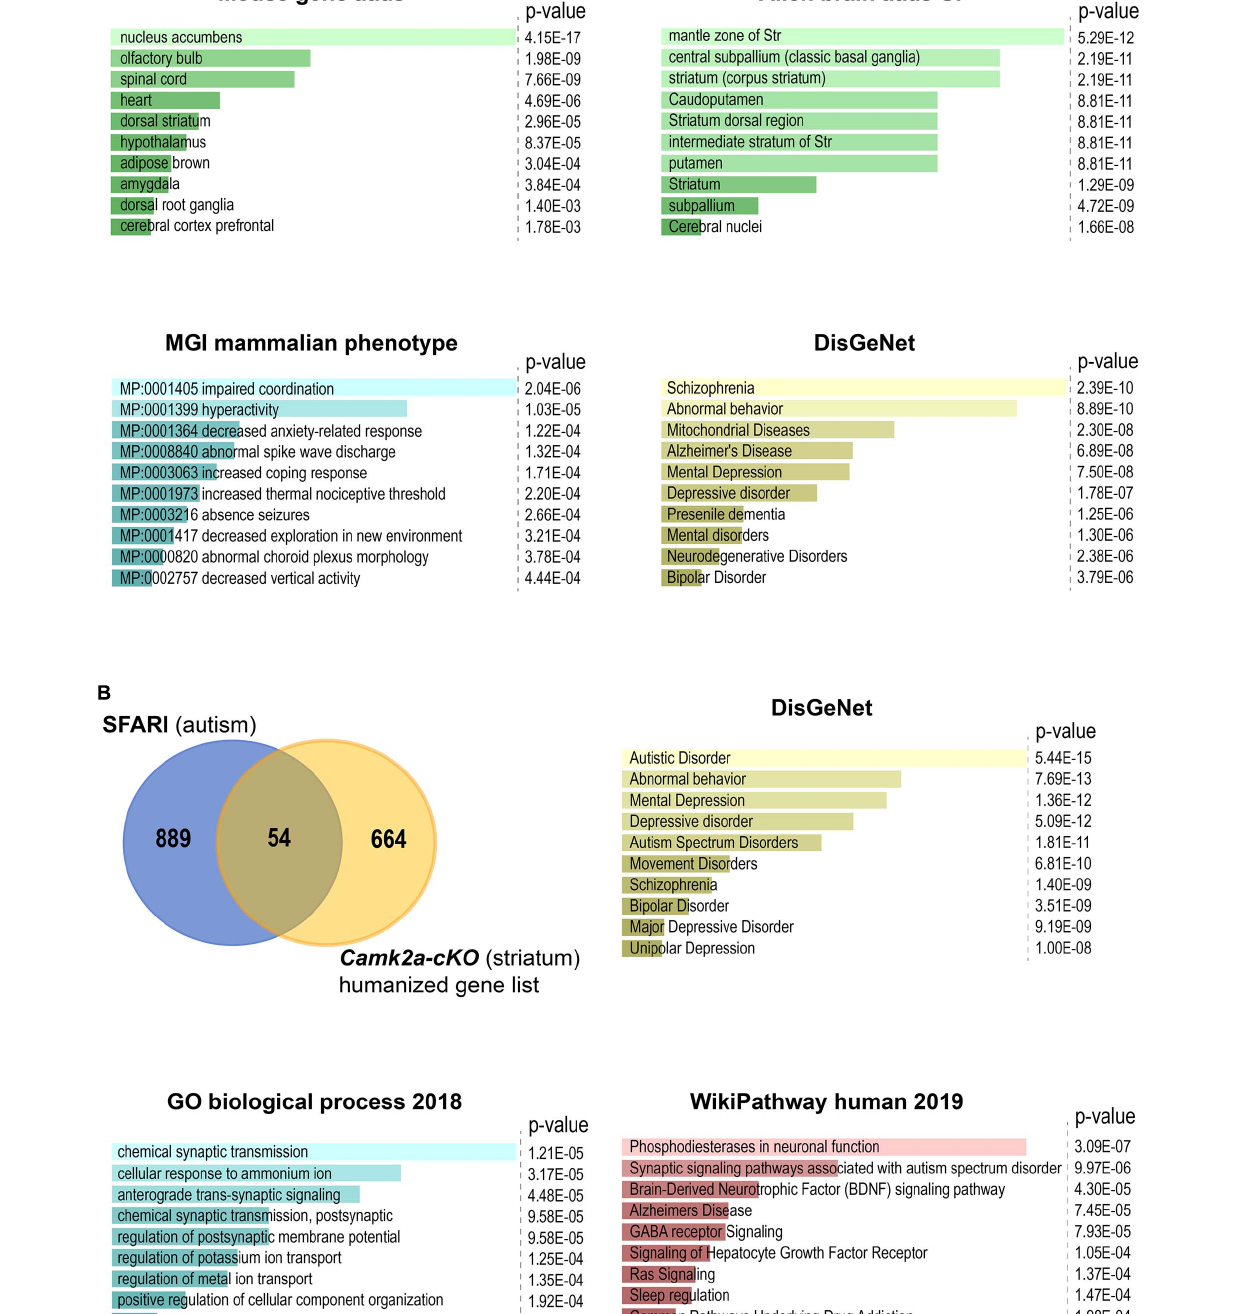
Frontiers in Genetics |